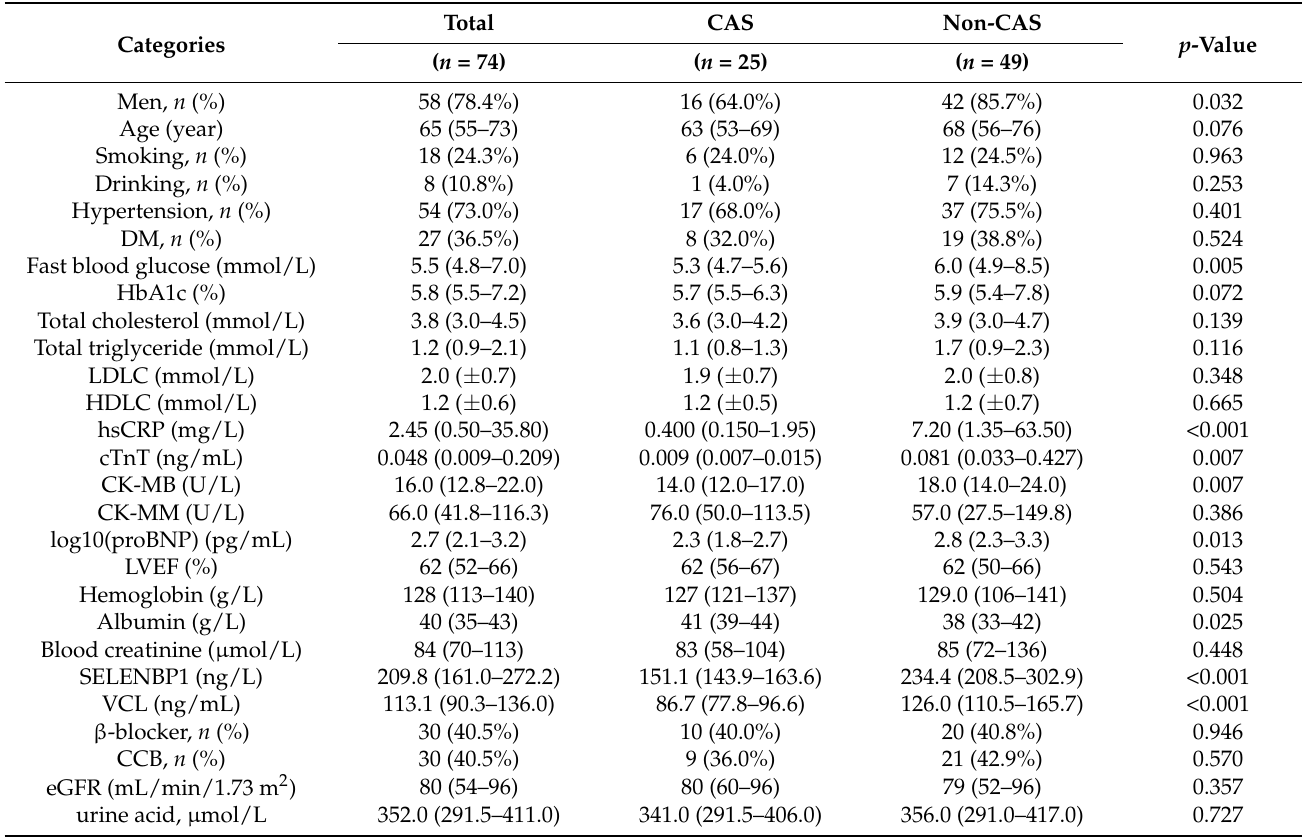
Table 1. Baseline characteristics of collected clinical samples from the two groups of patients.